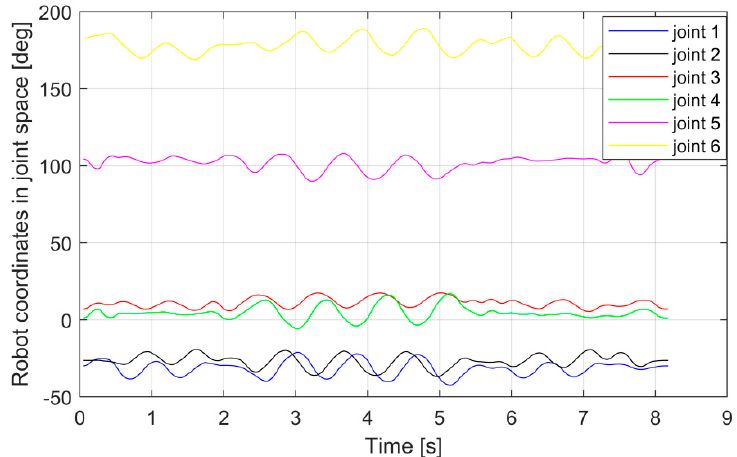
Figure 9. Robot coordinates in joint space.